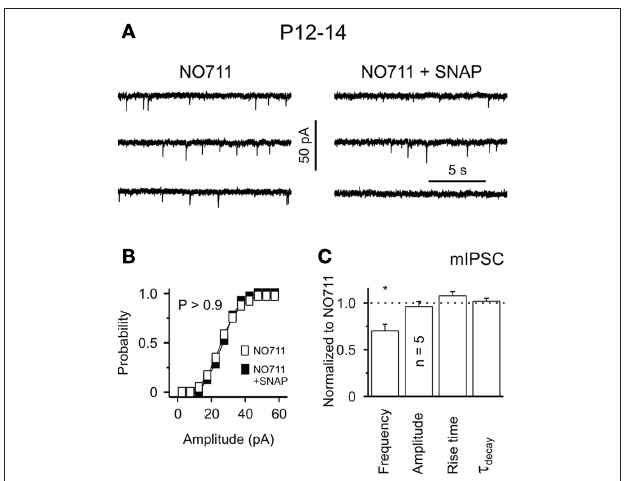
FiGurE 2 | Functional expression of GAT-2/3 is unmasked by suppression of GAT-1 activity in the rat striatum. (A) Sample traces showing mIPSCs in the presence of NO-711 (10 μM) and NO-711 plus SNAP 5114 (40 μM) in striatal slices of P12–14 rats. (B) Cumulative mIPSCs amplitude distribution was not significantly affected by SNAP 5114 ( P > 0.9, Kolmogorov–Smirnov test). Plot represents data from the cell shown in (A) . (C) SNAP 5114 – selectively decreased the frequency of mIPSCs. * P < 0.05. Reprinted from Kirmse et al. (2009) with permission from John Wiley